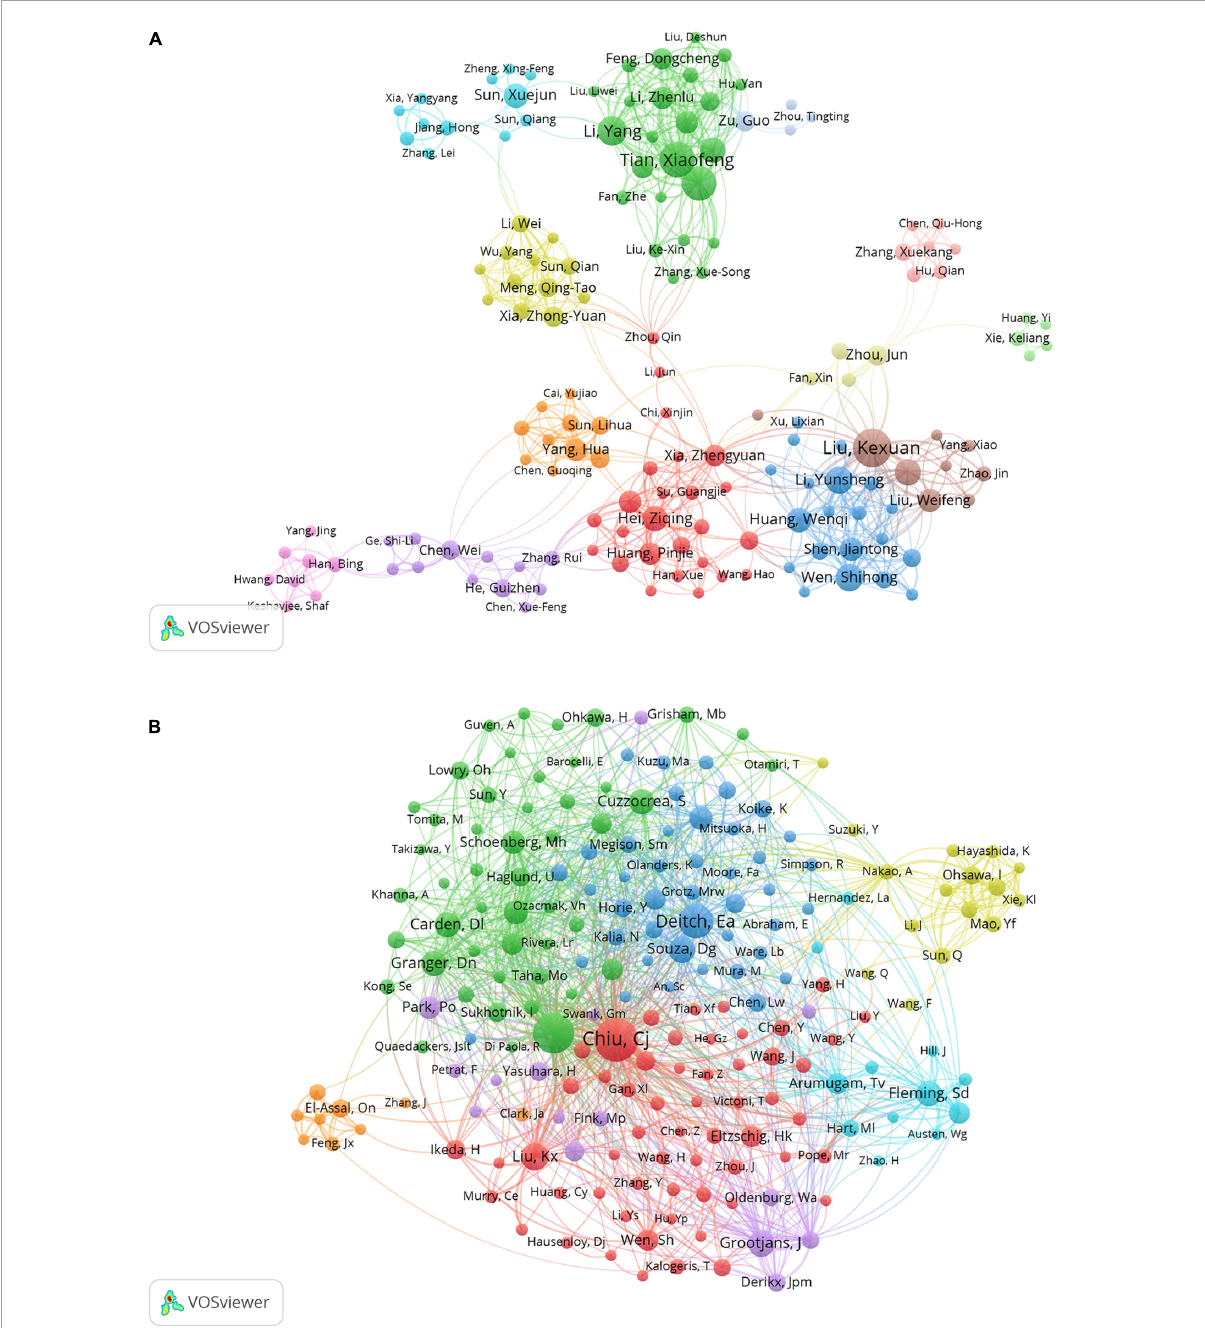
FIGURE4 Visualization of association graphs of co-authors and co-cited authors in intestinal I/R. (A) Network visualization diagram of collaboration among authors. Sizes of nodes represent publications of authors. Different colors each represent a closer collaborative relationship. The thickness of the inter-author linkage represents the strength of the relationship. (B) Network of co-cited authors. Sizes of nodes represent co-citations of authors. Chiu, Cj has the highest number of co-citations.